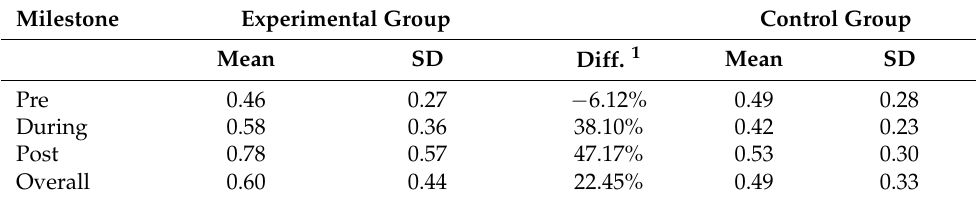
Table 6. Classroom participation data collected by